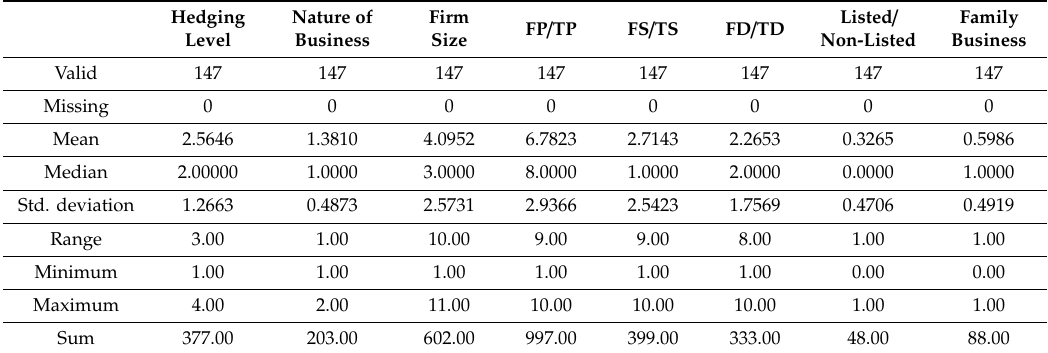
Table 1. Descriptive analysis to all variables included in the research